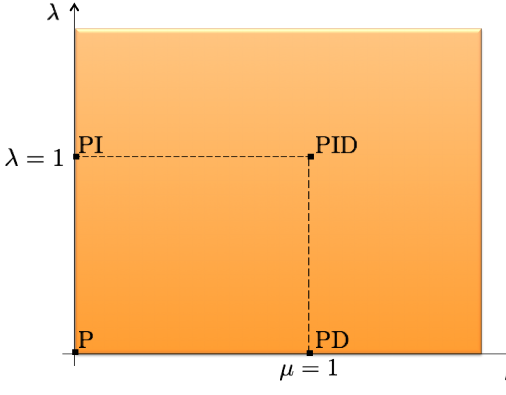
Figure 11. Parameters in the FOPID